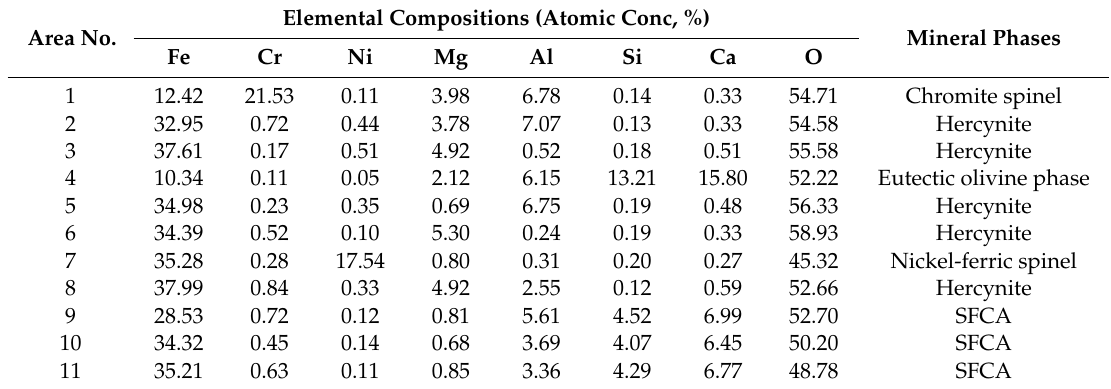
Table 5. EDS analysis results for the areas in Figure 10. Area No.